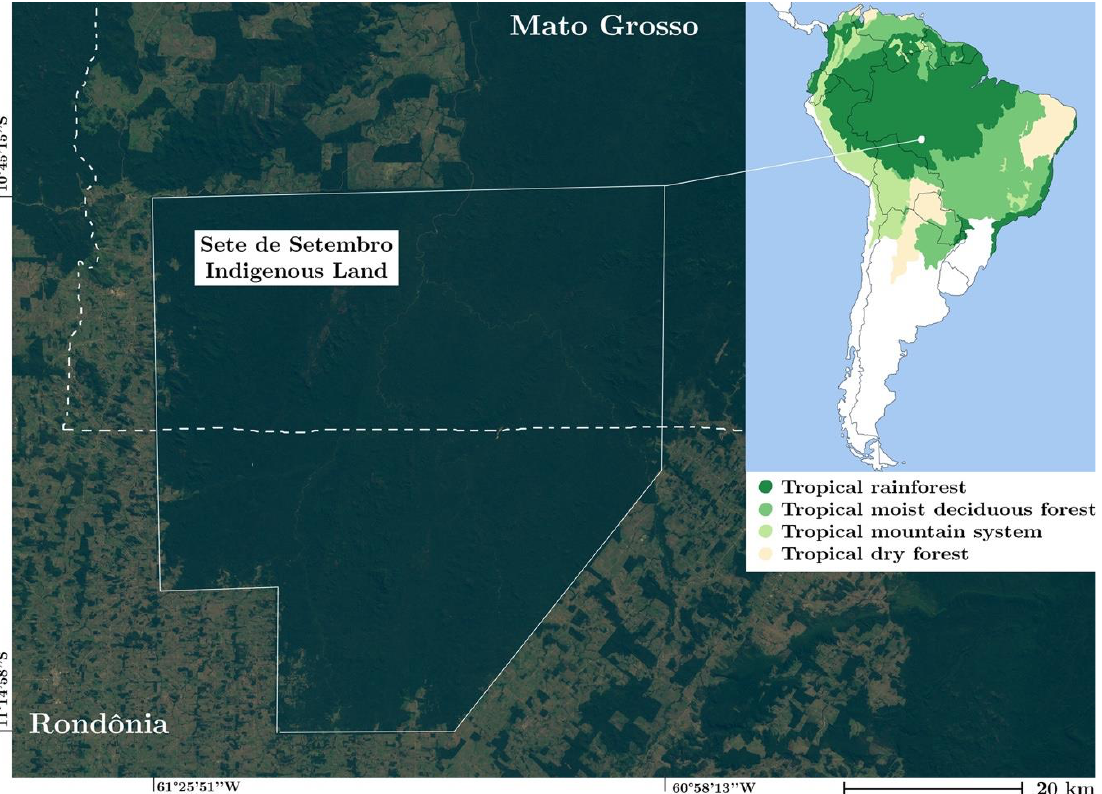
Figure 1. The Sete de Setembro Indigenous Land in true colors (Bands 2-3-4) on Sentinel-2 satellite images. Insert: the SSIL contextualized in its eco-region (from FAO 2010).